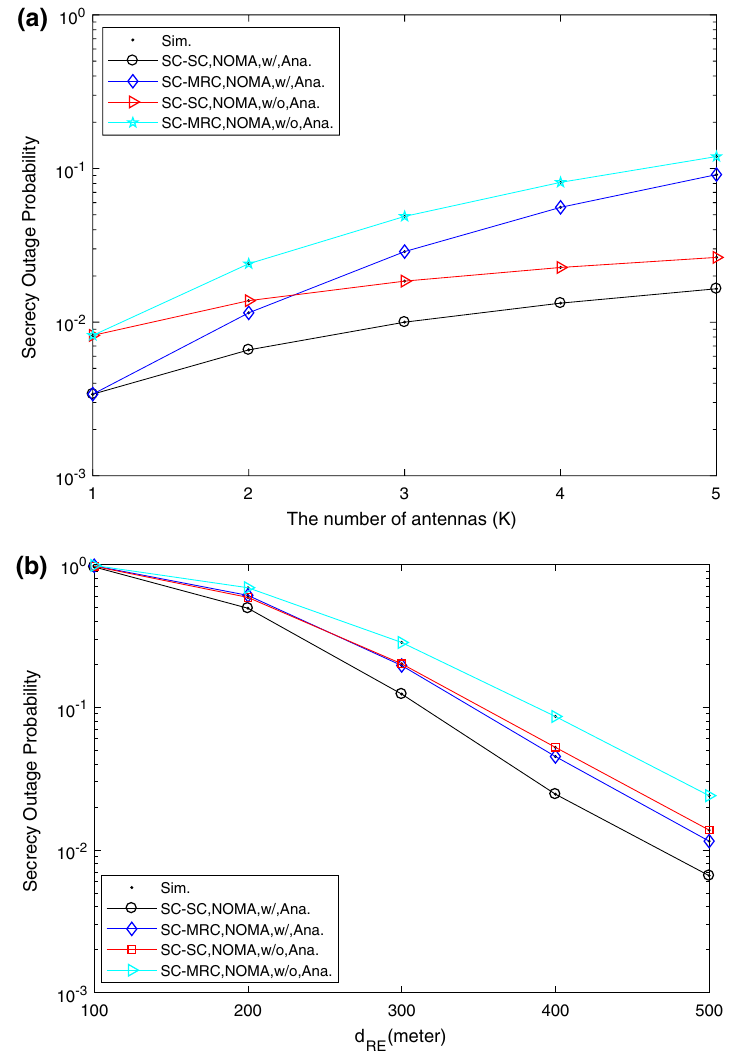
Fig. 7 The effects of the eavesdropper on SOP. ( a ) The different number of antenna on eavesdropper; ( b ) The different eavesdropping distance. When the transmission power is constant, the impact of the number of antennas and eavsdropping distances is on the